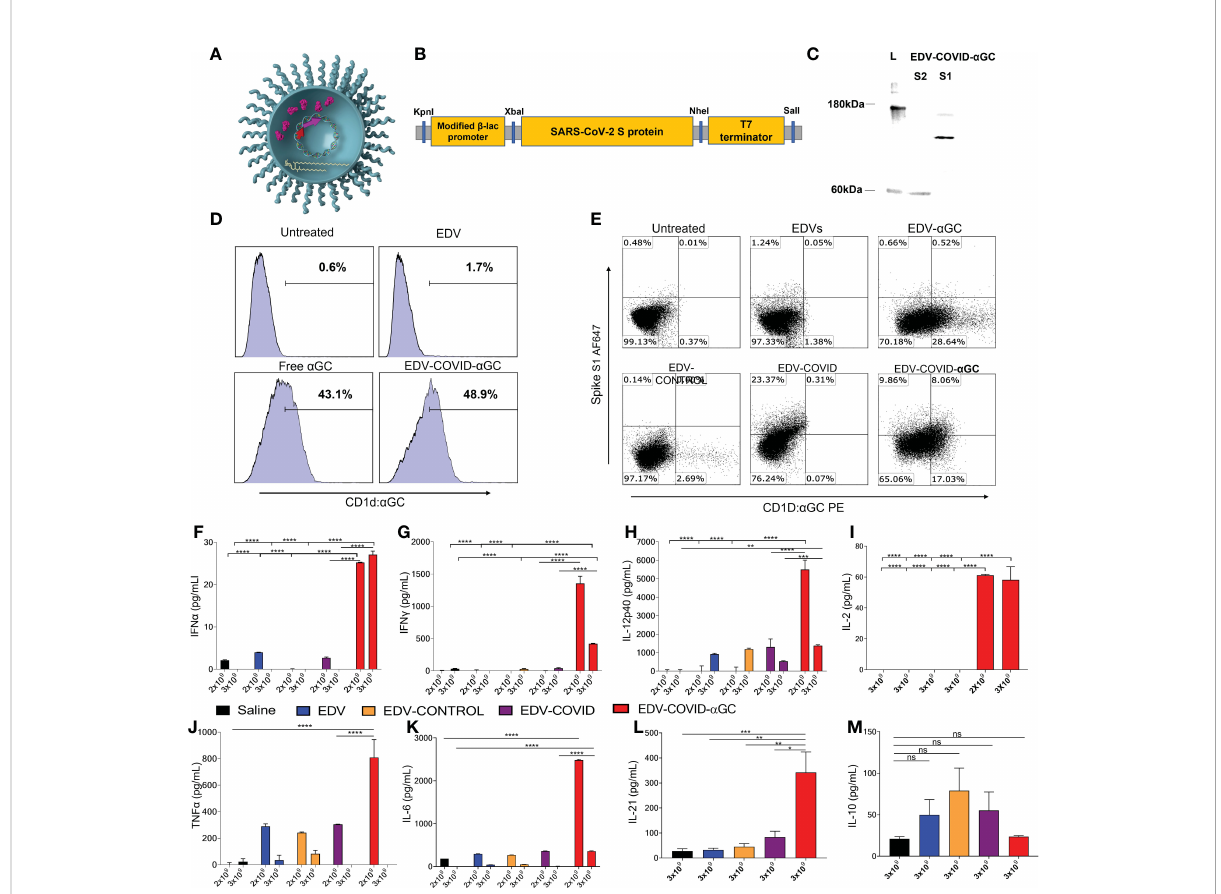
FIGURE 1 EDV-COVID- a GC formulation, antigen/ a GC co-presentation and early cytokine response in mice. (A) Image of EDV-COVID- a GC depicting the LPS, membrane and nanocell contents including plac-CoV-2 plasmid, S-protein and a GC. (B) Construct: SARS-CoV-2 S-protein nucleotide sequence (Genbank MN908947.3) at the 3 ′ -end of a modi fi ed constitutive gene expression b -lactamase promoter and inserted between KpnI 5 ′ and SalI 3 ′ sites of the M13 multiple cloning site of pUC57-Kan backbone plasmid to create plac-CoV-2. (C) Western blot analysis using MAbs against the S1 and S2 subunit demonstrated the presence of the S-protein within EDV-COVID- a GC. (D) FACS analysis showing that EDV- COVID- a GC was able to effectively deliver a GC into murine bone marrow derived, JAWSII, cells and presented through CD1d-ligand to a similar ef fi ciency as free a GC. (E) Co-staining of JAWSII cells with anti-CD1d: a GC and anti-spike Abs demonstrating a GC and S-protein delivery by EDVs with EDV-COVID- a GC delivering both S-protein and a GC on the same cell surface. (F – H) IFN a , IFN g , IL-12-p40 levels at 8 h post dose 1 following I.M. injections of female BALB/c mice (n=6) with 2 and 3 (x 10 9 ) EDV-COVID- a GC or various controls. (I) IL-2 levels in 2 x 10 9 and 3 x 10 9 EDV-COVID- a GC particle dose after 8 h post dose 1. (J, K) TNF a and IL-6 levels in 2 x 10 9 and 3 x 10 9 EDV-COVID- a GC or